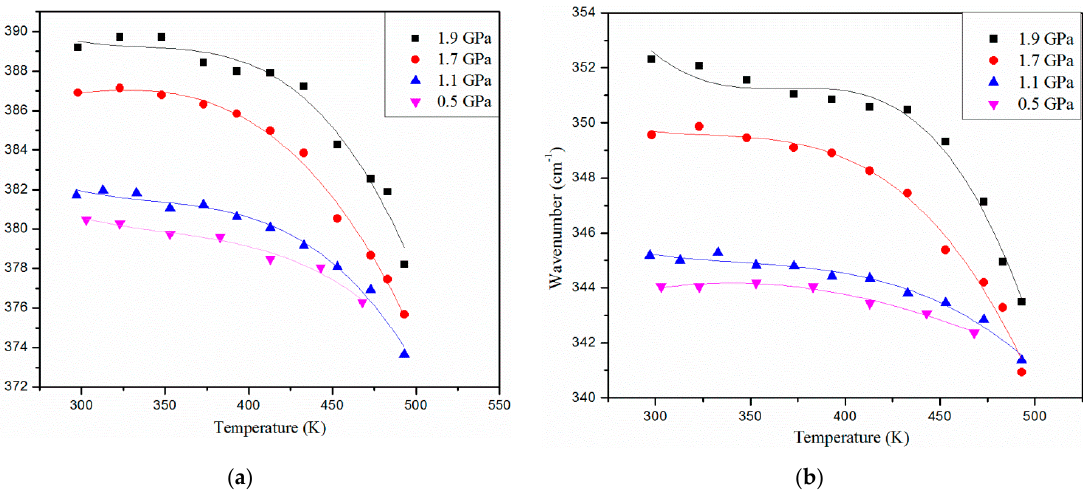
Figure 8. ( a ) Raman shift of A(g) mode heating at different initial pressures: 0.5, 1.1, 1.7, 1.9 GPa; ( b ) Raman shift of E(g) mode heating at different initial pressures: 0.5,1.1, 1.7, 1.9 GPa.